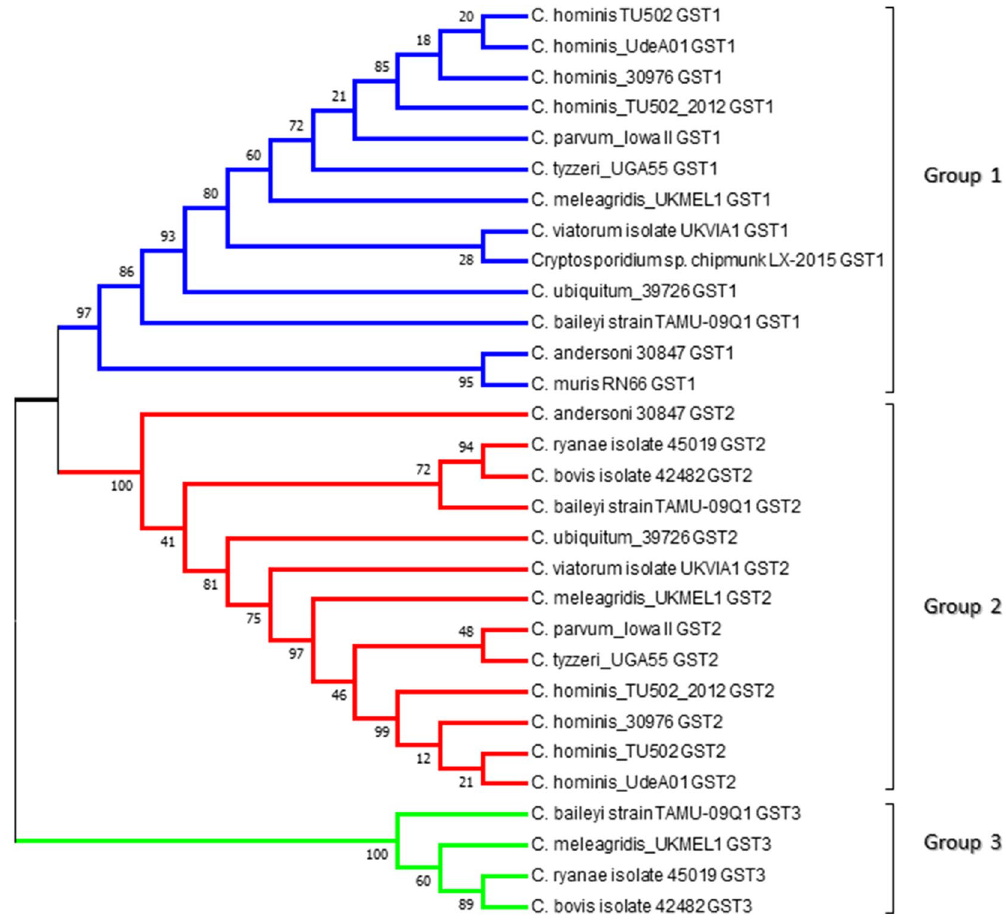
Figure 1. Phylogenetic analysis of glutathione transferase (GST) proteins from Cryptosporidium species. The evolutionary history was inferred by using the maximum likelihood method based on the JTT matrix-based model 63 . Evolutionary analyses were conducted in MEGA7 62 . The percentage of trees (bootstrap value) in which the associated taxa clustered together is shown next to the